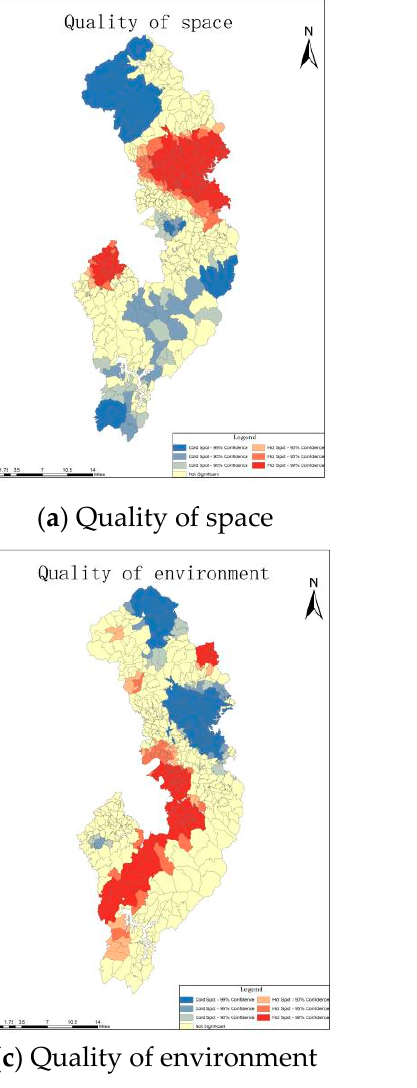
Figure 6. Spatial agglomeration and distribution of cold and hot spots in the spatial quality, functional quality and comprehensive quality of cultivated land in Qujiang